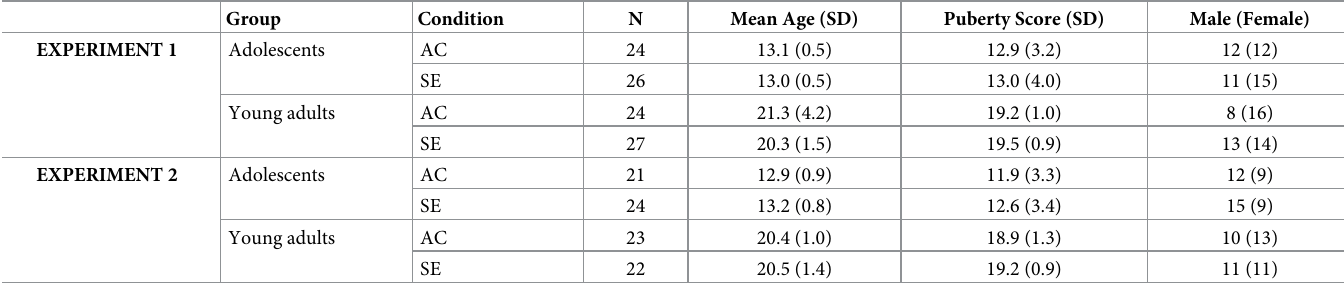
Table 1. Characteristics of the sample